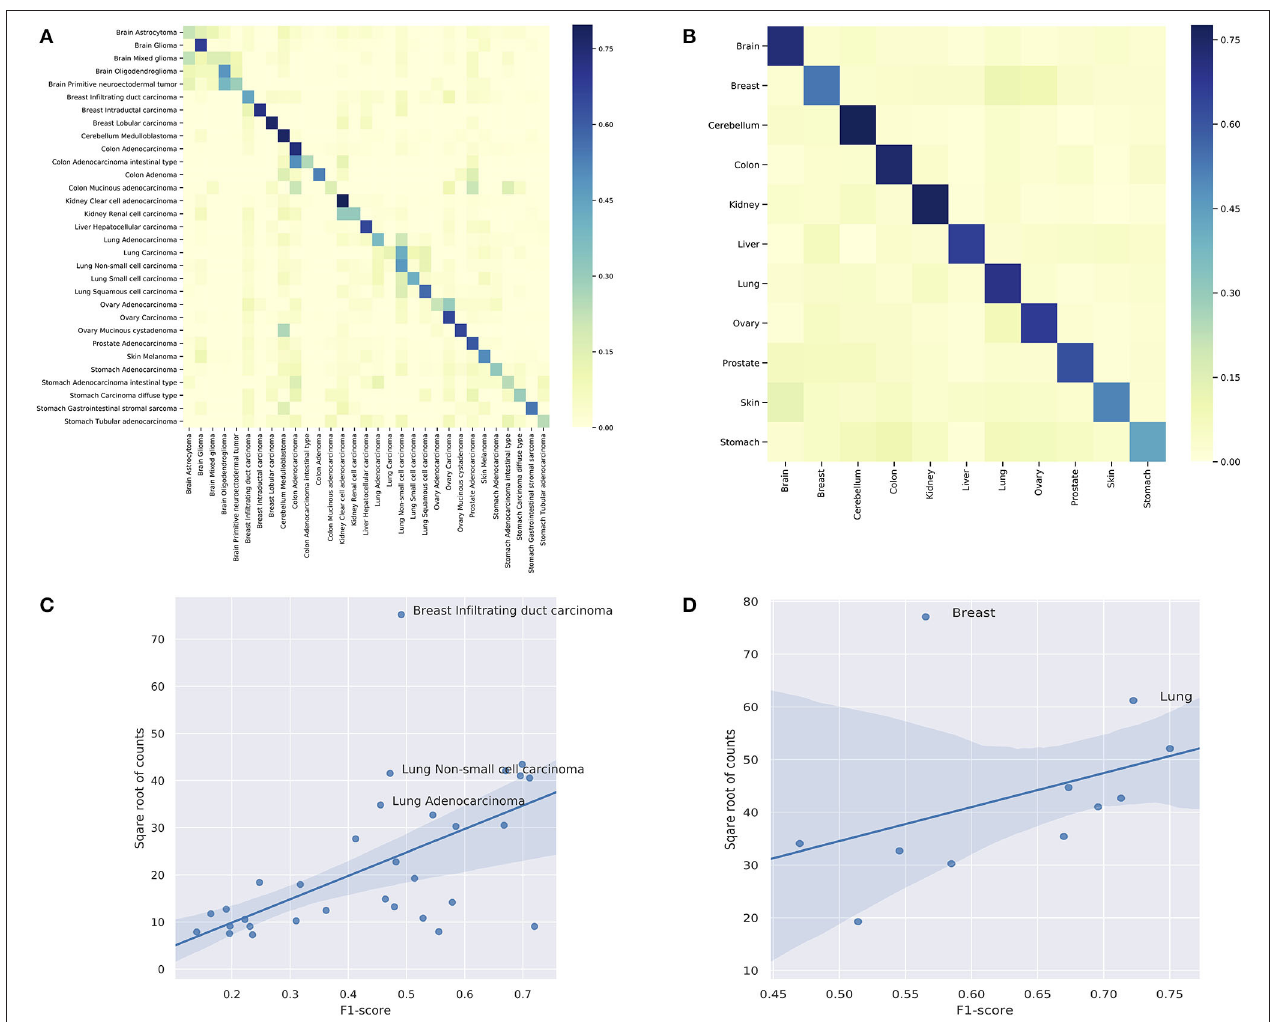
FIGURE 7 | (A) The classification performance of individual subtypes. (B) The classification performance of individual organs. For (A,B) , the x-axis are true labels, and the y-axis are predicted labels. (C) The correlation between the performance and the number of samples in the classification of subtypes. (D) The correlation between the performance and the number of samples in the classification of